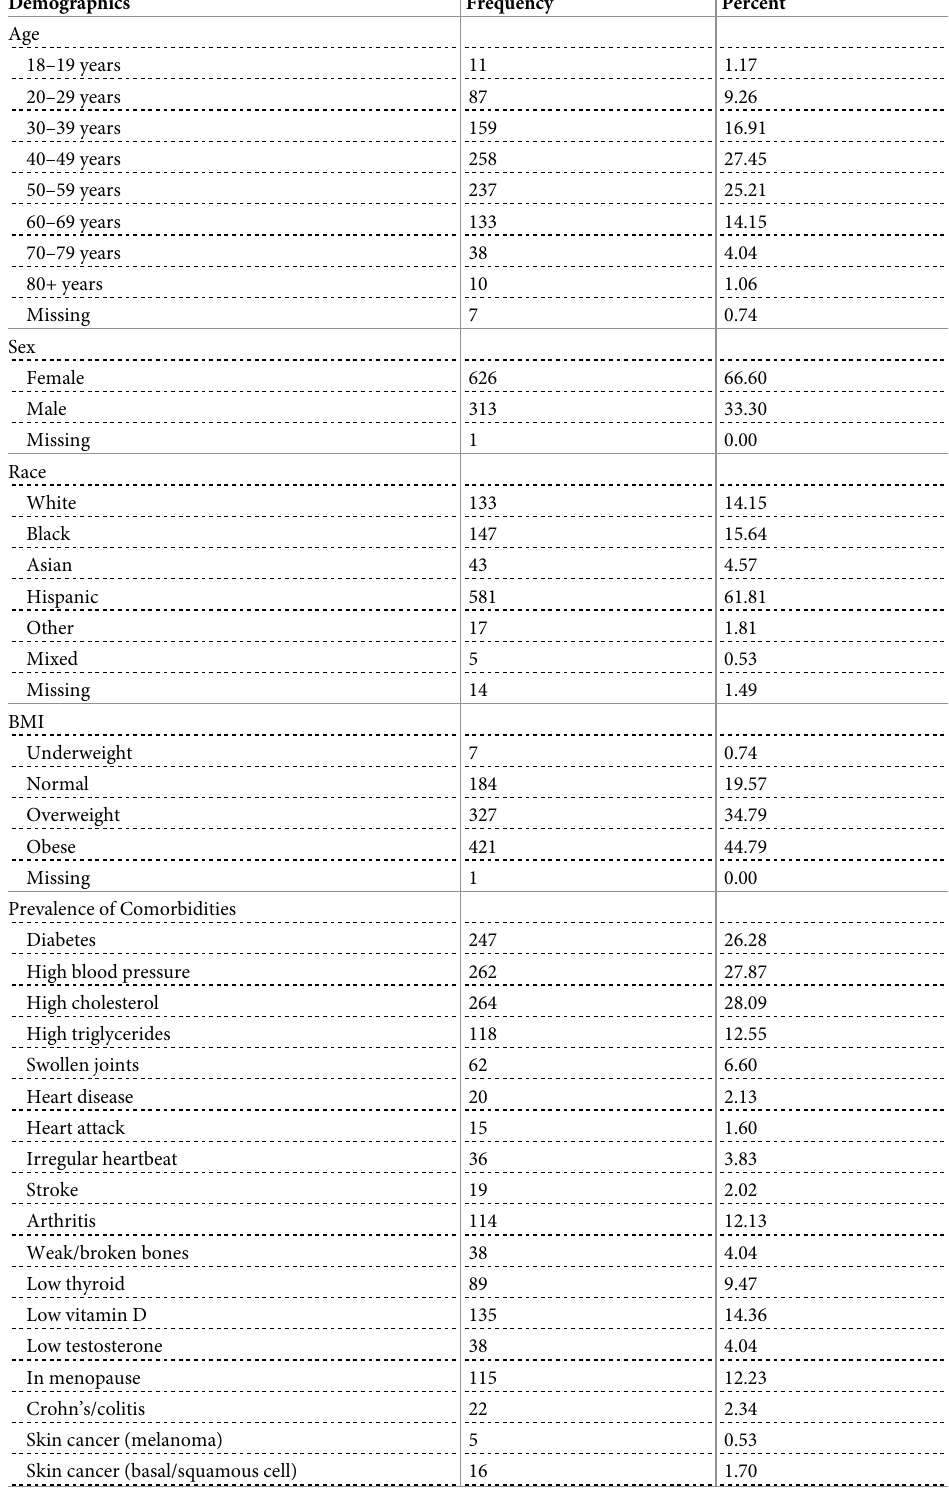
Table 3. Demographics of study